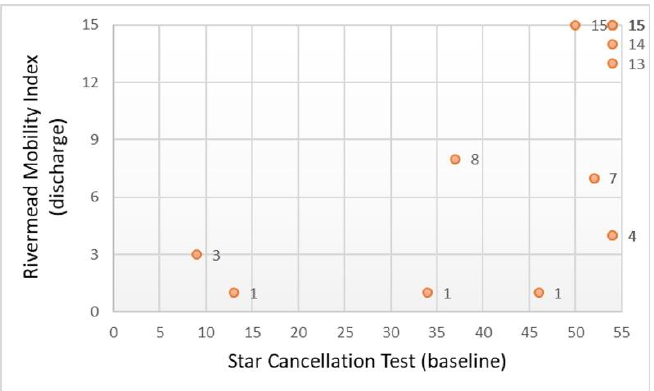
Figure 4. Scatter plot showing the relationship between the cancellation test and daily mobility ( n = 17).